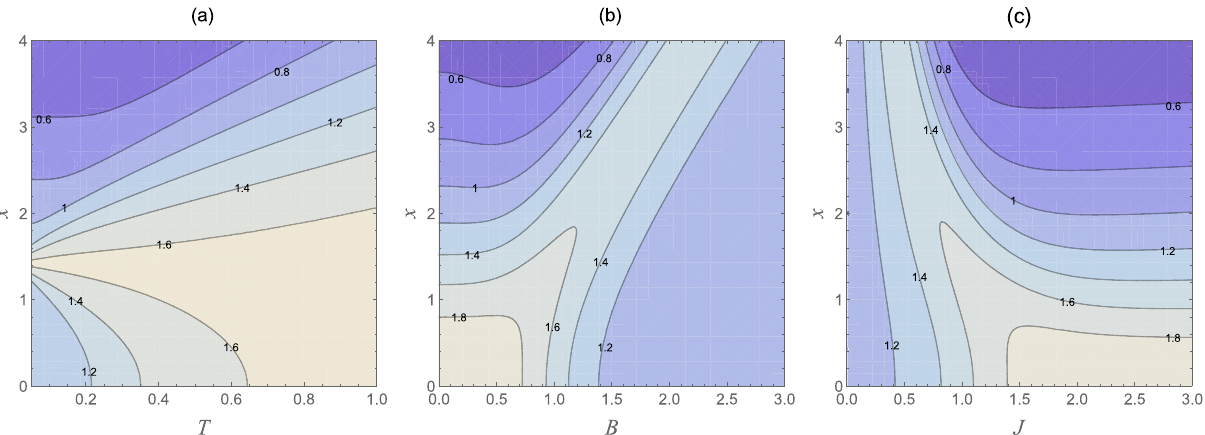
Figure 5. The entropic uncertainty bound U b (ρ T ,2 ) as a function of the inhomogeneity parameter x and different values of the temperature T , external magnetic field B , and the coupling constant J . Graph ( a ) B = 1; J = 1 , graph ( b ) T = 0.5 ; J = 1 , and graph ( c ) T = 0.5 ; B =